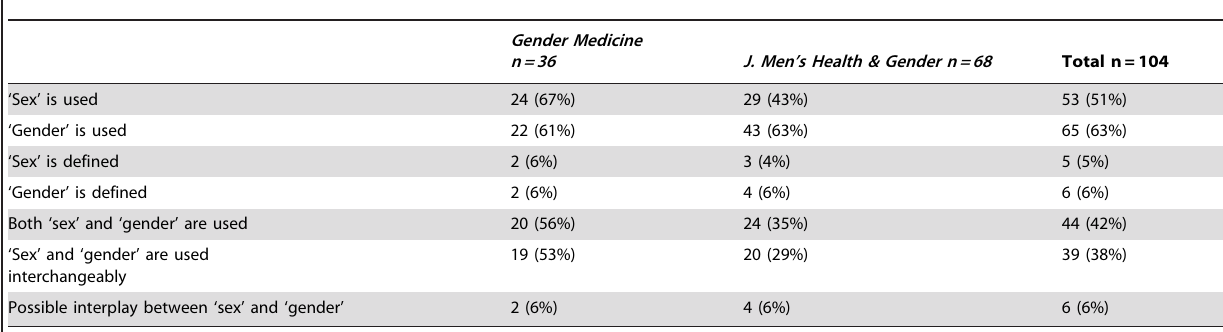
Table 2. Quantitative content analyses of the papers from the two